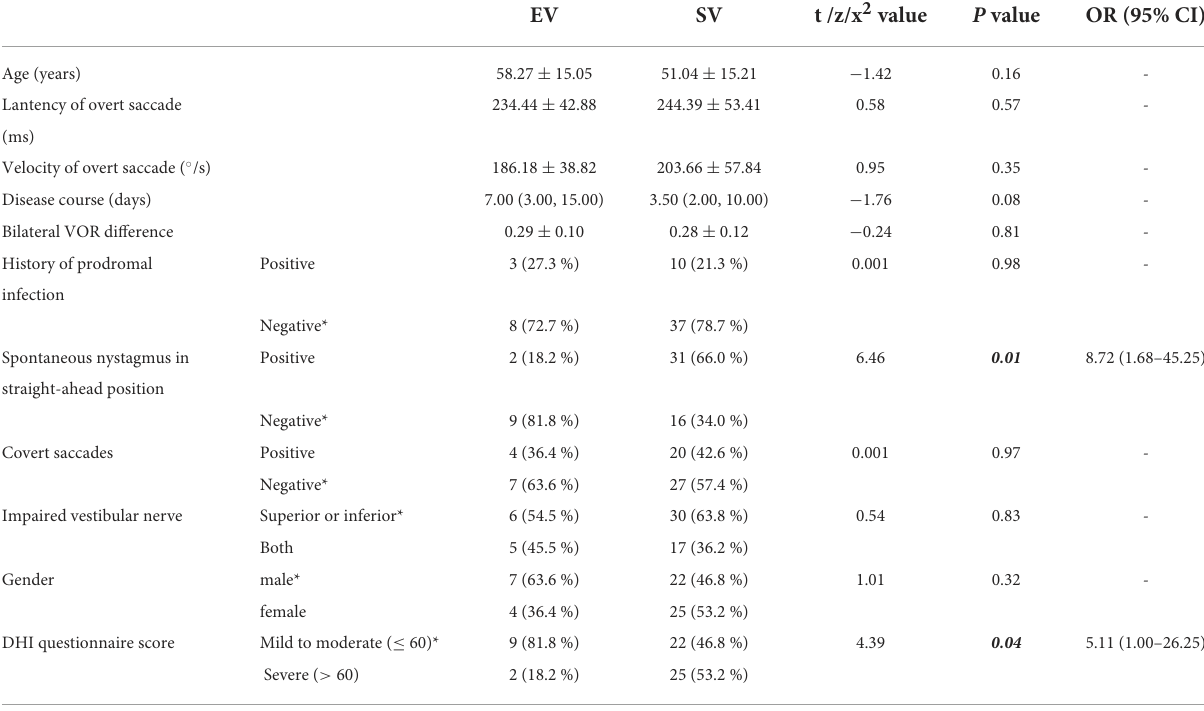
TABLE 3 Statistical analysis between patients in the episodic vertigo (EV) group and the sustained vertigo (SV)